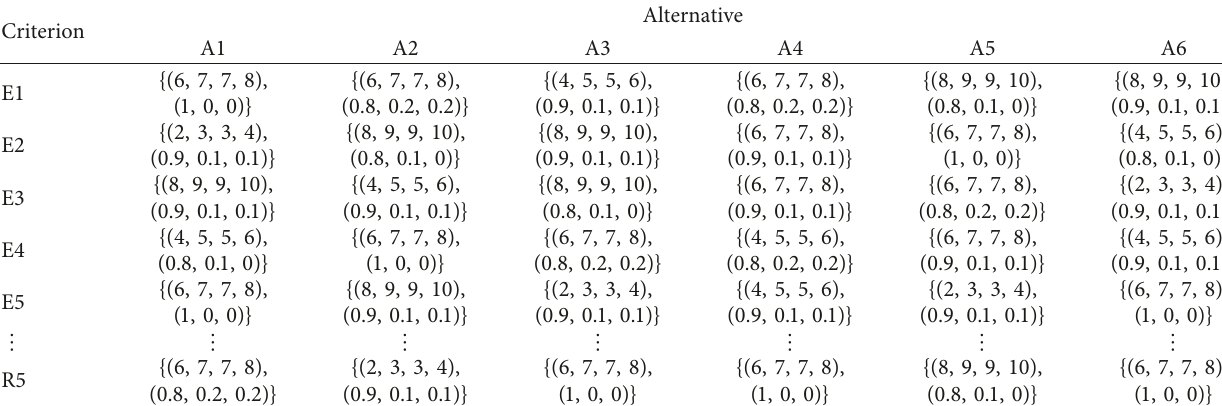
Table 10: Performance data of the six alternative partners